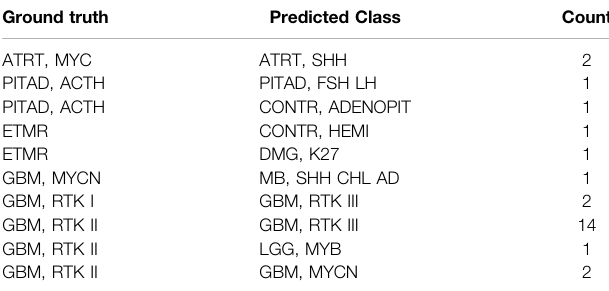
TABLE 2 | The incorrect prediction result in the independent test set. The fi rst column is the true label, the second column is the predicted result, and the third column is the number of the corresponding